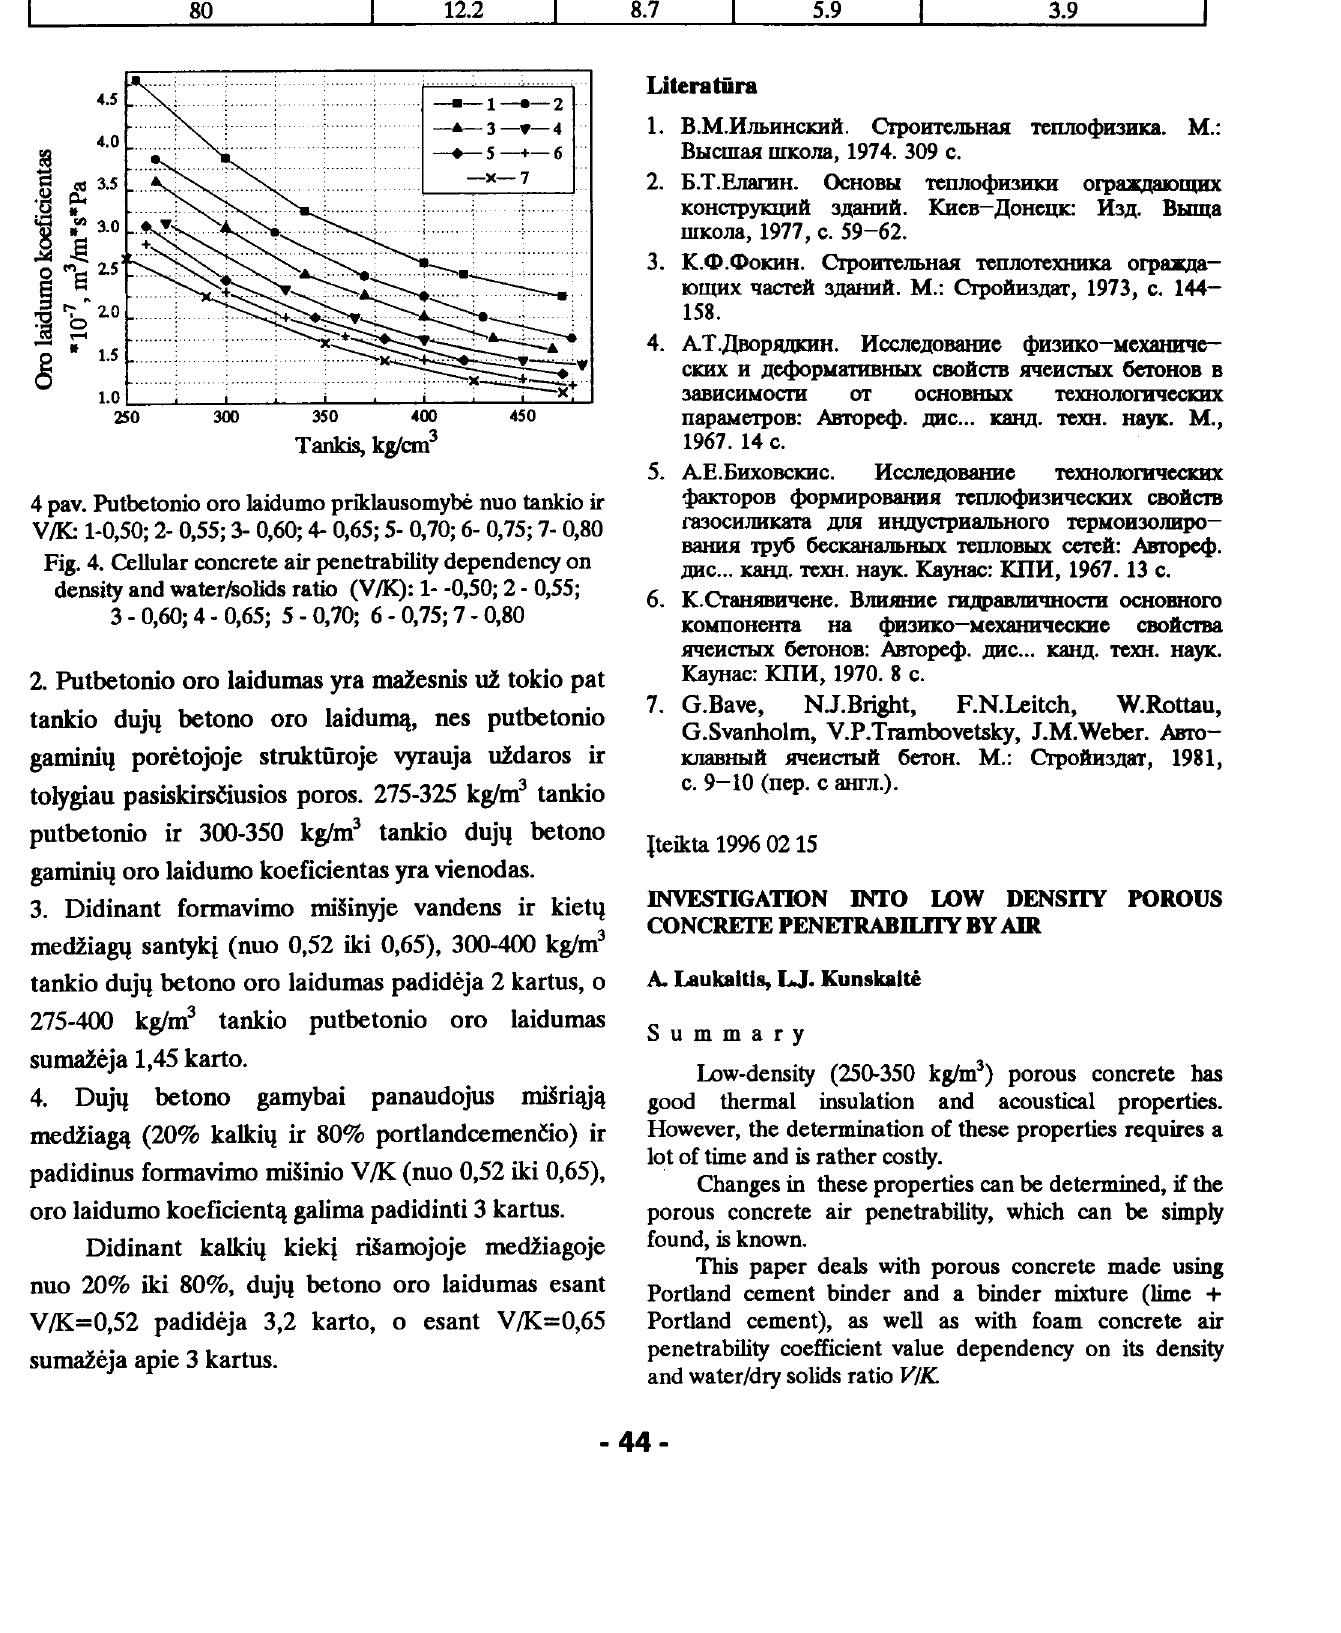
Ri§amosios medziagos sudetis: